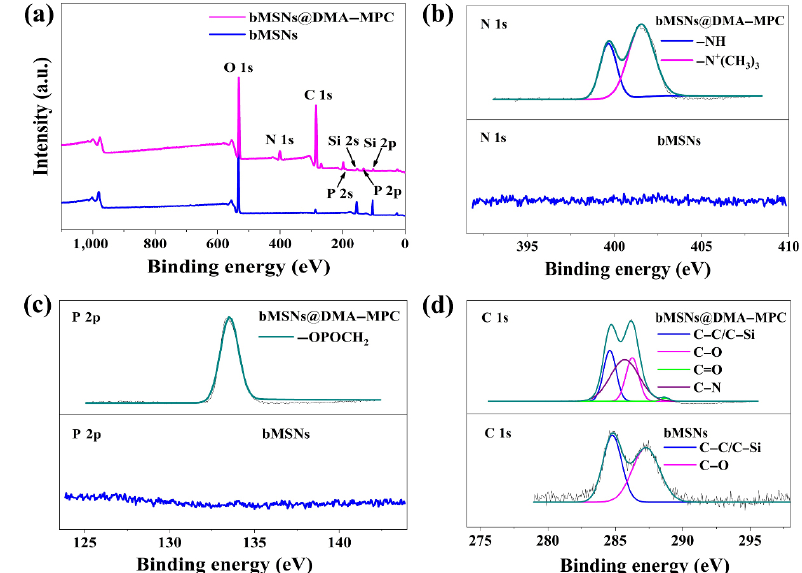
Fig. 4 XPS spectra of bMSNs and bMSNs@DMA–MPC (1:4) nanoparticles. (a) Comparison of the XPS spectra between the nanoparticles. Deconvolution analysis of the nanoparticles for (b) N 1s, (c) P 2p, and (d) C